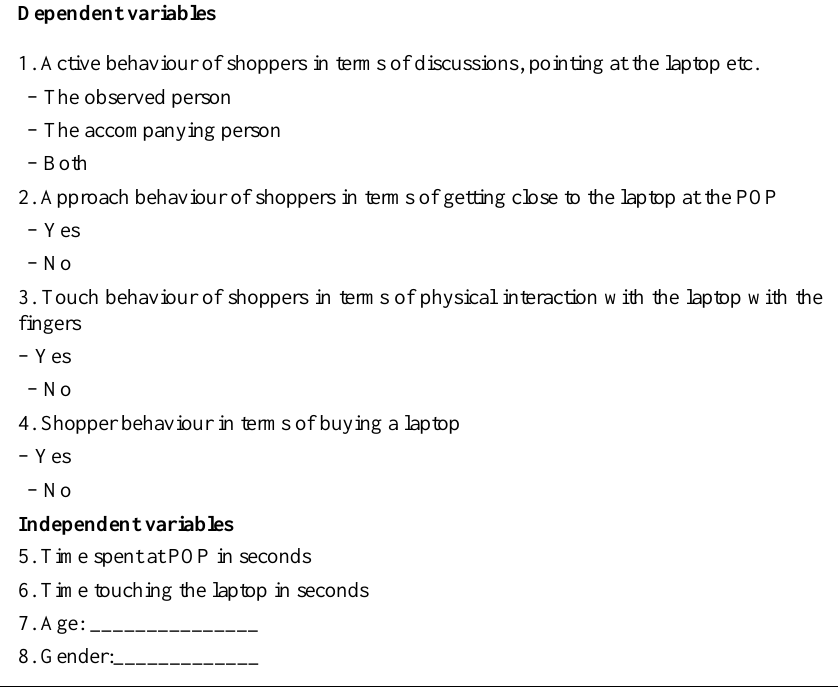
Table 1. Observation